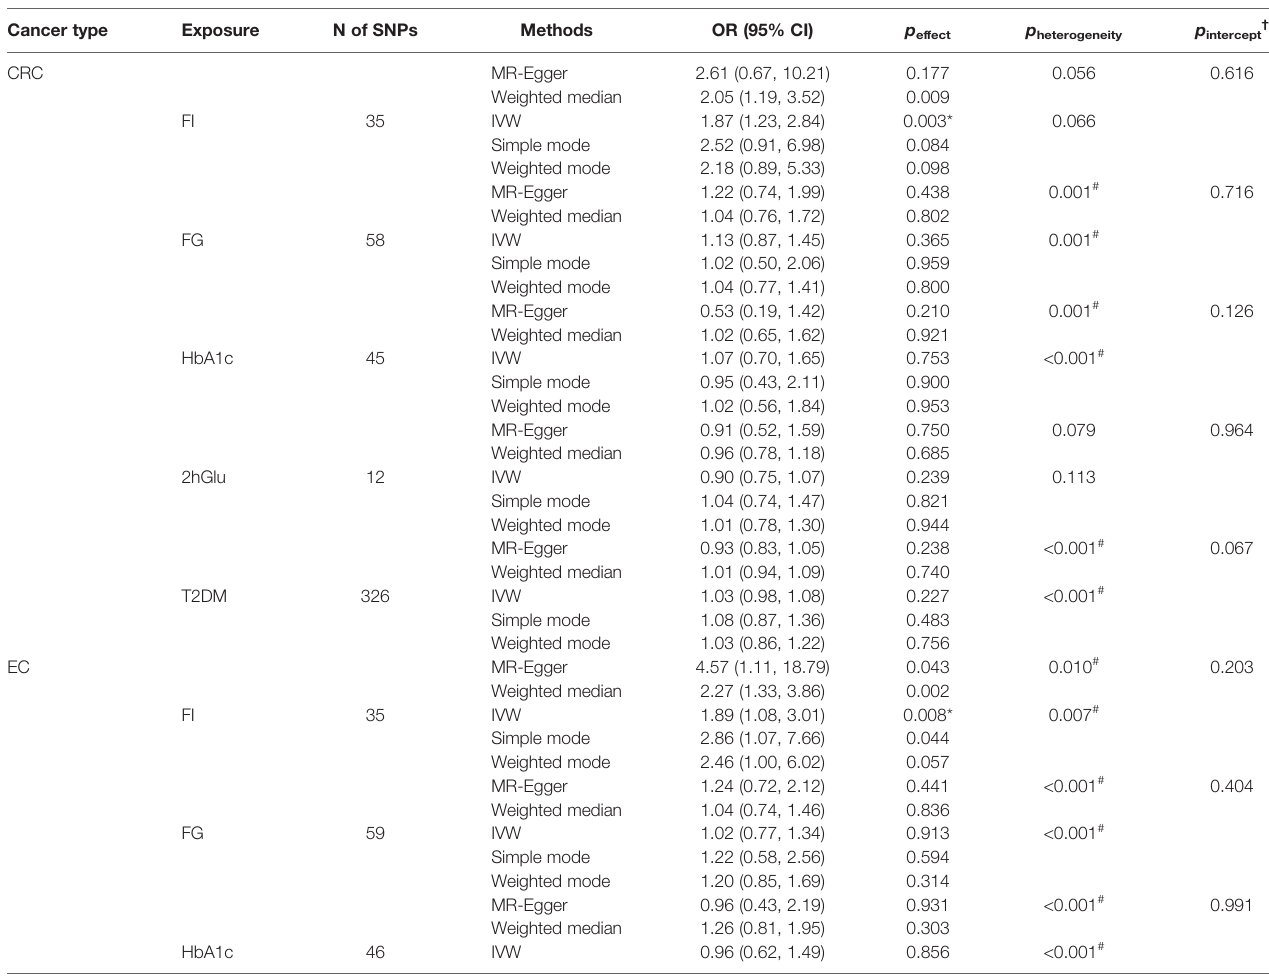
TABLE 1 | Two-sample MR analysis results of glycemic traits and T2DM on colorectal and endometrial cancers. Cancer